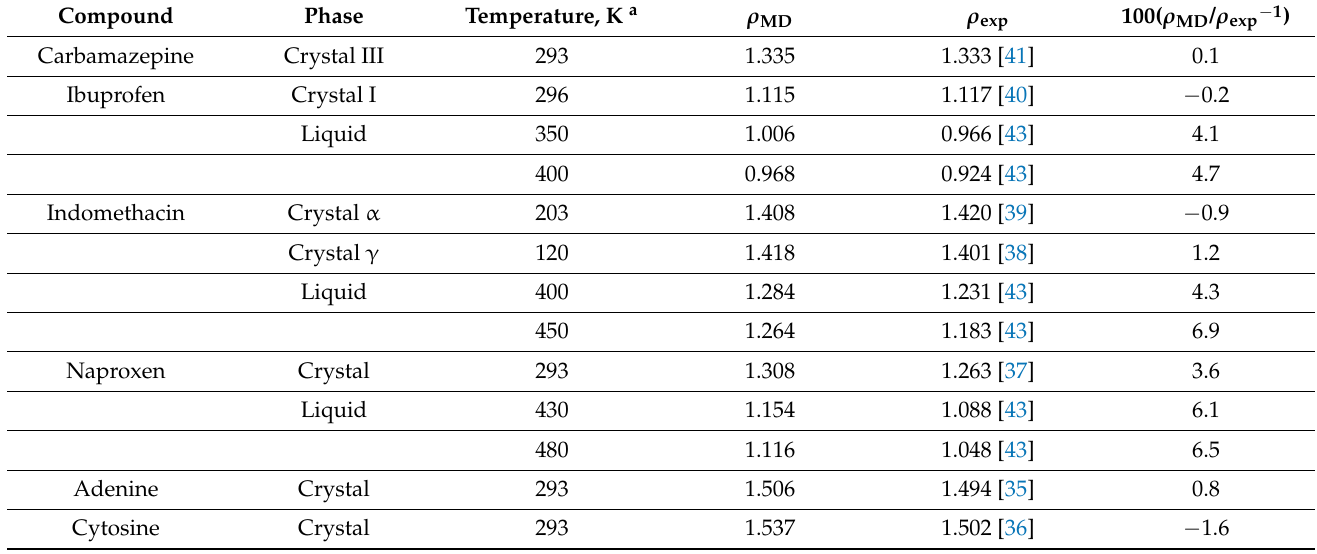
Table 2. Comparison of simulated and experimental bulk phase densities ρ (g · cm − 3